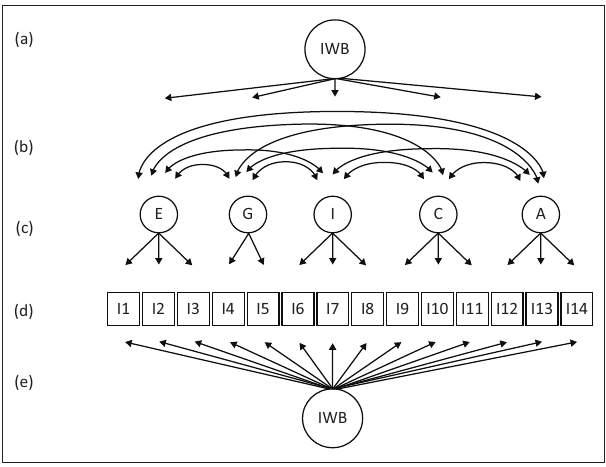
FIG URE 1: Measurement models for the innovative work